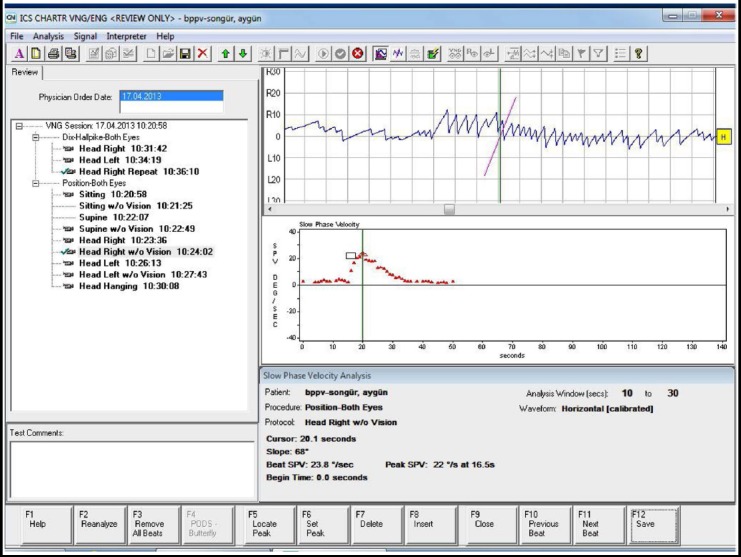
VENG test reports.